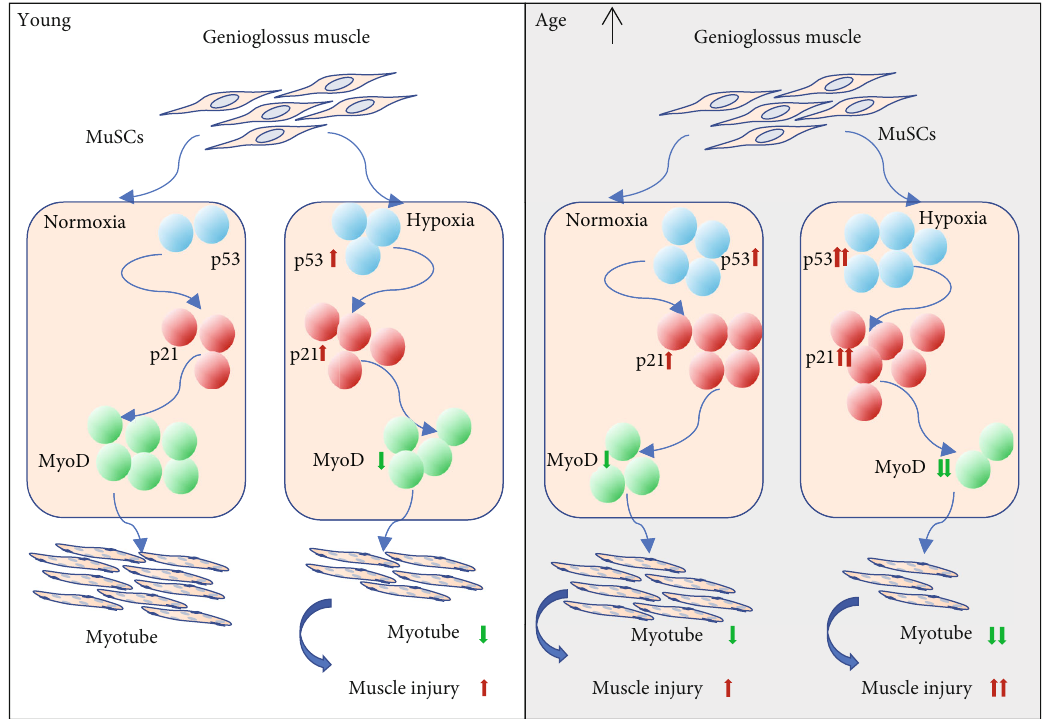
Figure 7: The diagrammatic sketch shows the damage mechanism of hypoxia and aging to genioglossus. Under hypoxia, increasing p53 and p21 induce the decline of MyoD. Then, low expression of MyoD leads to the reduction of myotube formation, especially in aging MuSCs. Finally, the results above enhance upper airway muscle